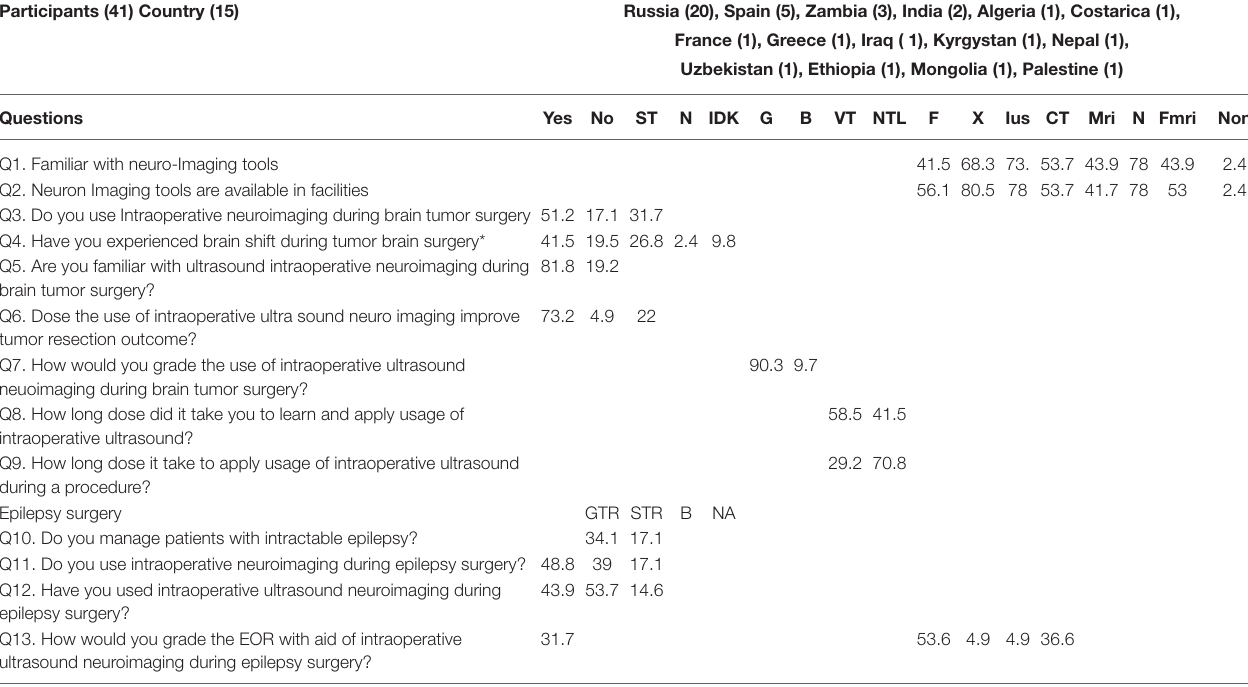
TABLE 1 | Survey on the applicability of IUS in neurosurgery as a neuronavigation tool. Participants (41) Country